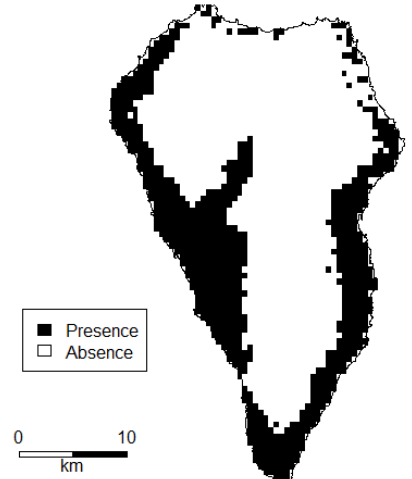
Figure A2. Projected suitable habitat of P. setaceum on La Palma as a result of the ensemble model based on a GLM, GBM, GF, and MaxEnt model. Conversion of the modeled habitat suitability into a presence/absence-based map on 0/1 was done using the AUC (area under the relative operating characteristic curve) cutoff of the weighted mean with a threshold value of 509.5, scaled to 0.5095 in Figure 2.